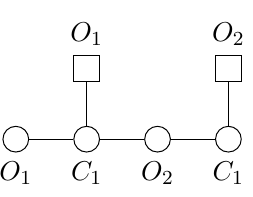
Figure 69. Quiver obtained from brane system in the third row of table 6. Its Higgs branch is M H = A 3